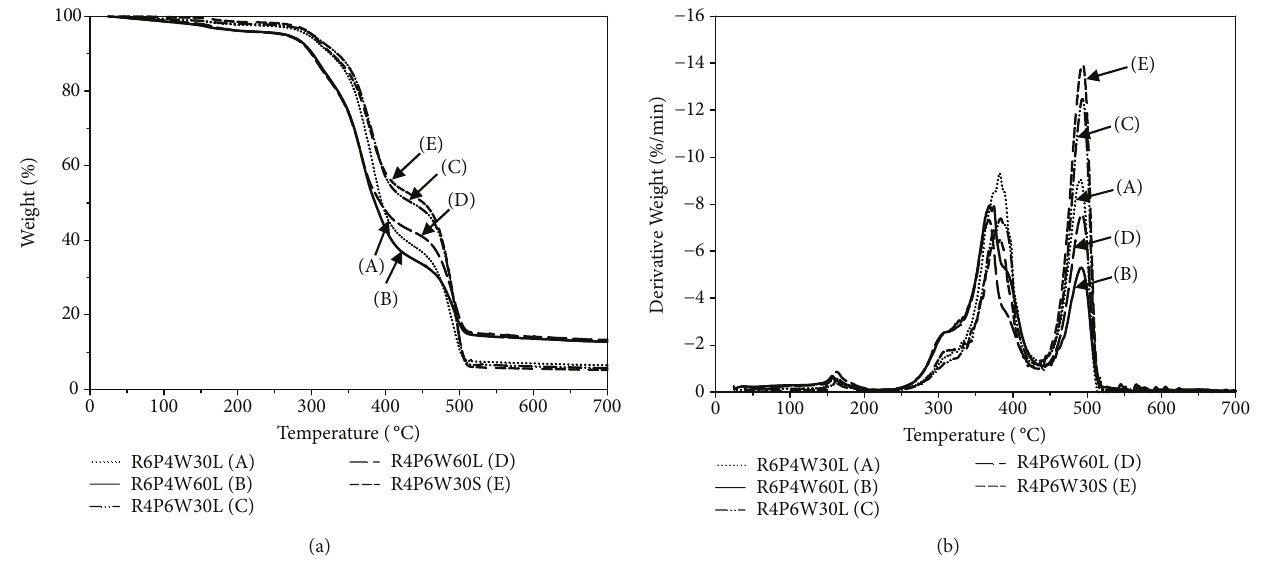
Figure 2: Curves of (a) TGA and (b) DTG for TPNR composites containing di ff erent RWS contents and sizes.